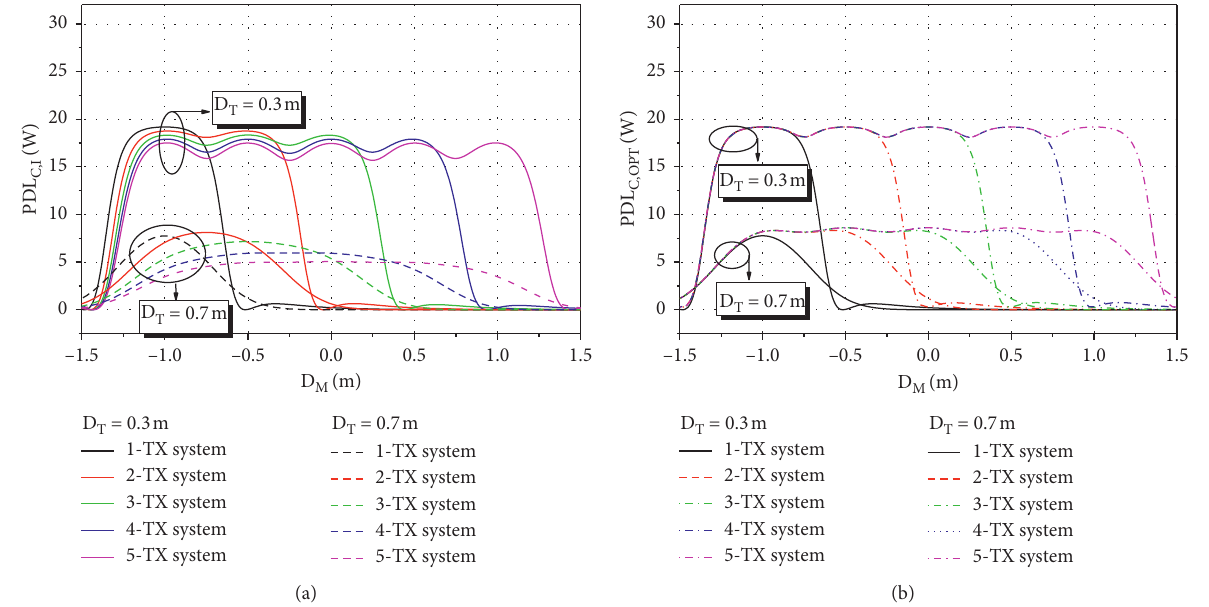
Figure 4: The PDLs for (a) EC Case and (b) OC Case under the P